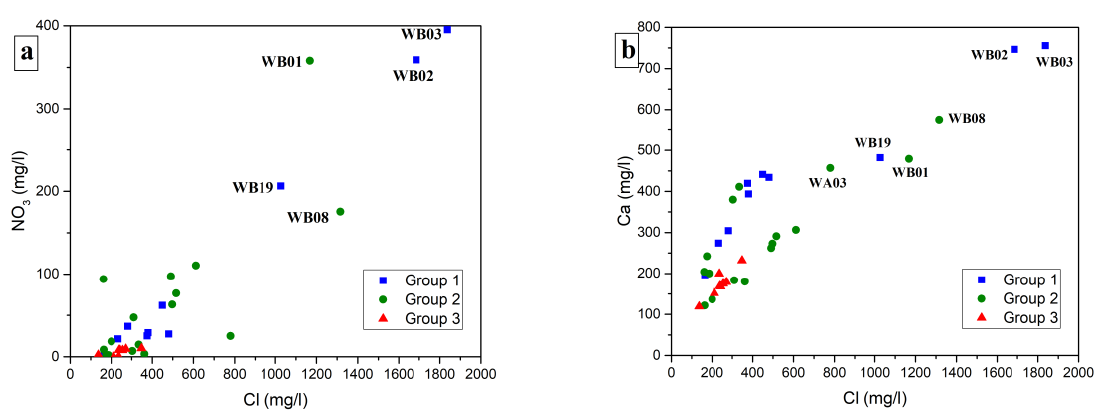
Figure 10. Cl − versus NO 3 − ( a ) and Cl − versus Ca 2 + ( b ) concentrations of 34 groundwater samples from the Al Kharj area.